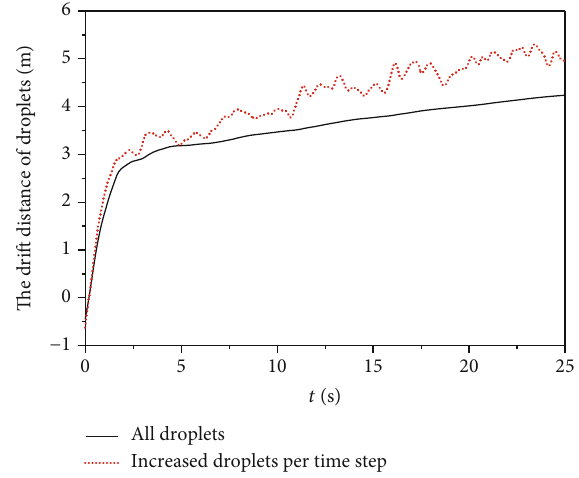
Figure 19: Droplet drift distance with the consideration of random lateral wind.